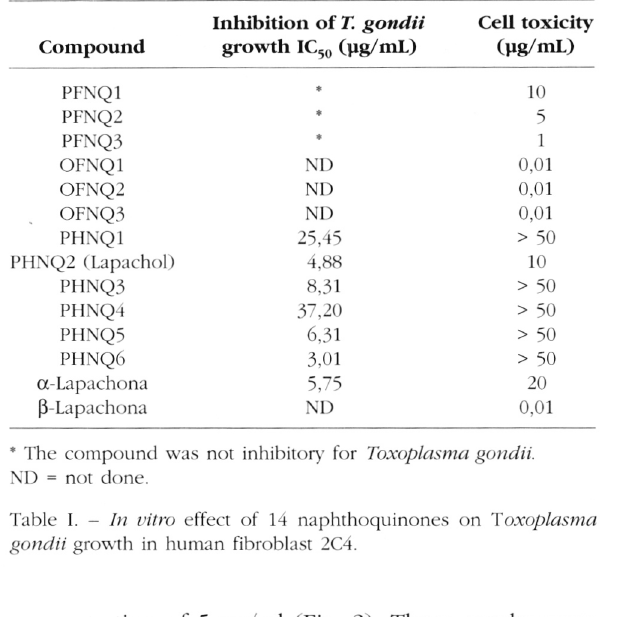
Table I. - In vitro effect of 14 naphthoquinones on Toxoplasma gondii growth in human fibroblast 2C4.